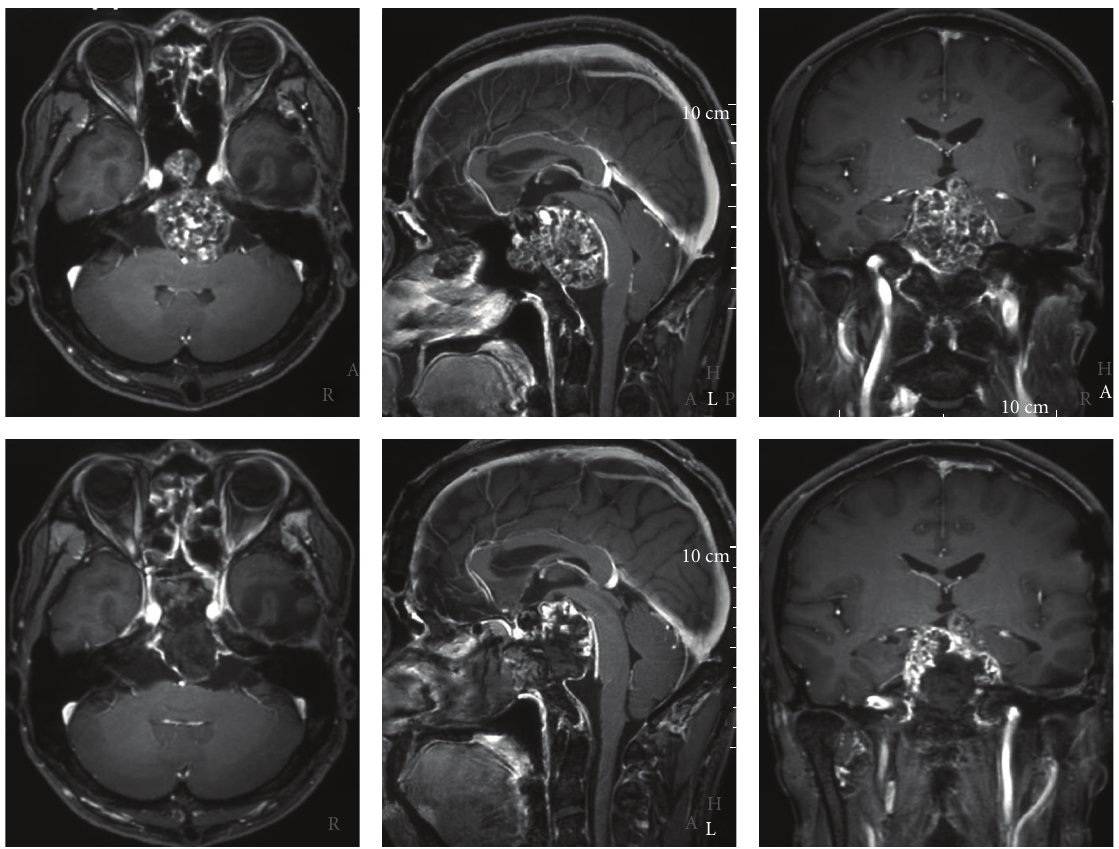
Figure 3: Case 2. Upper: MRI images after the second operation. Lower: MRI after transsphenoidal surgery. Tumor was resected except suprasellar part and decompressed